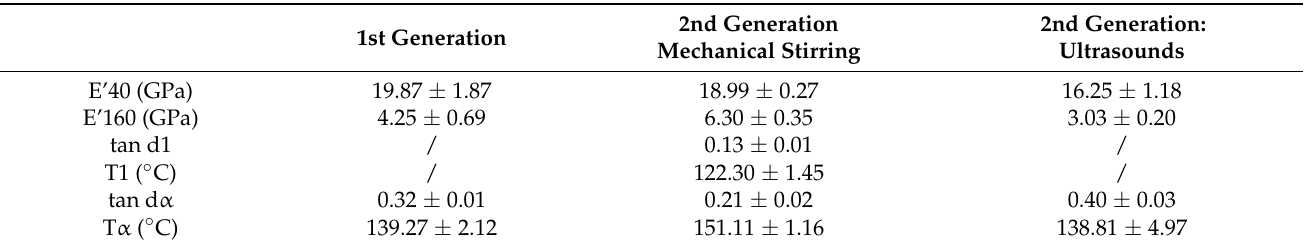
Table 4. DMA results of first generation composites and those recycled by mechanical stirring and